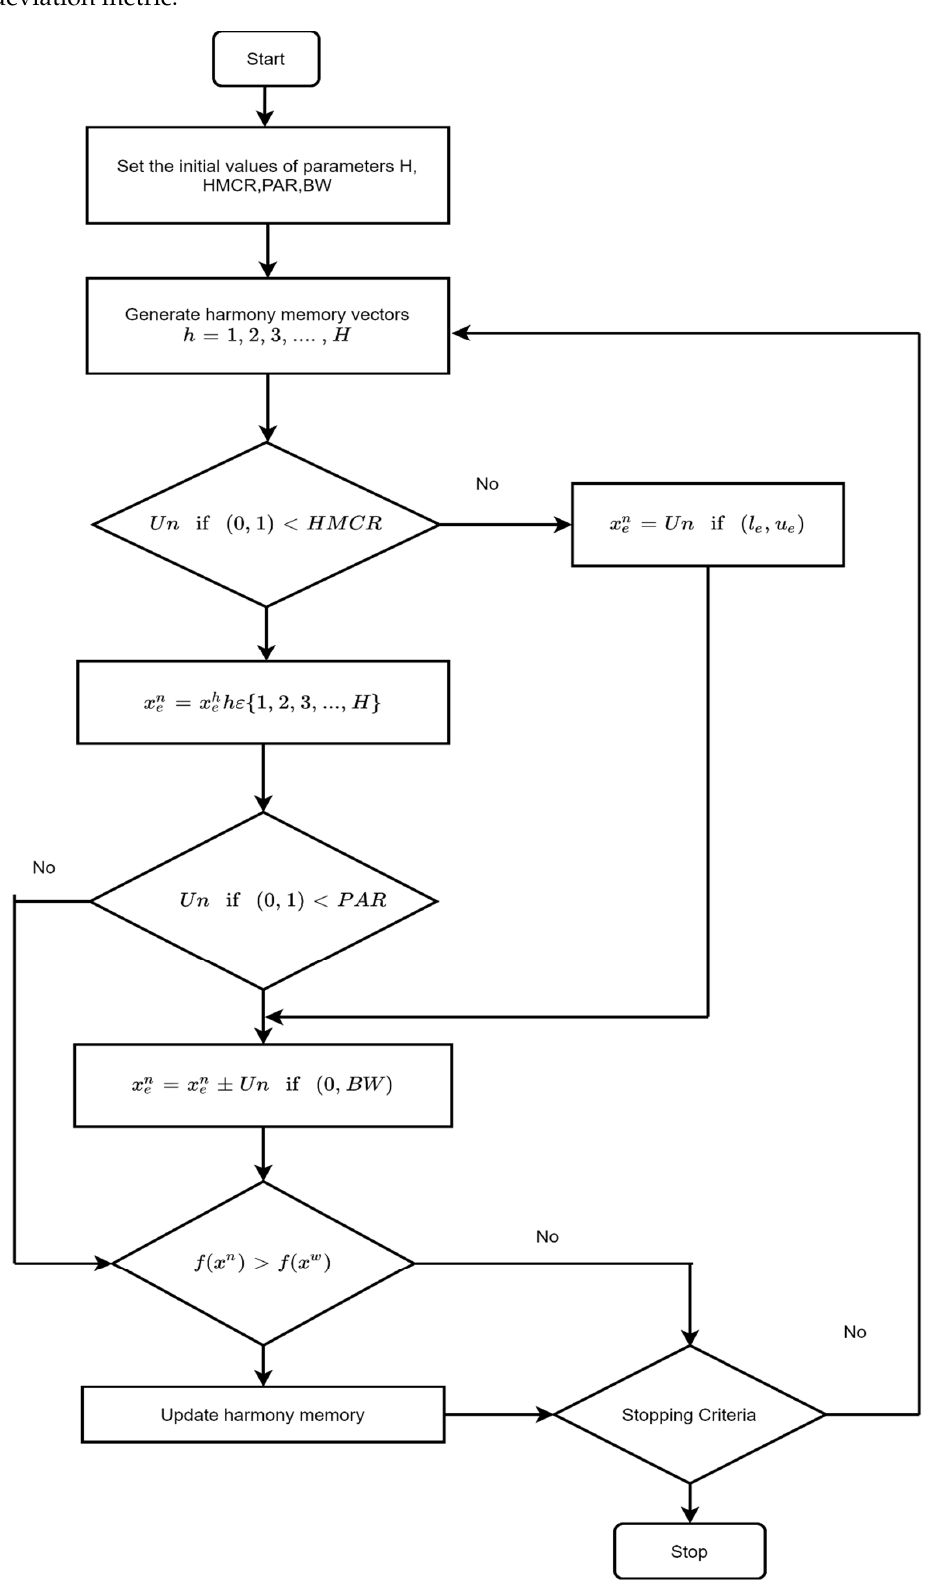
Figure 8. Framework of Harmony Search.